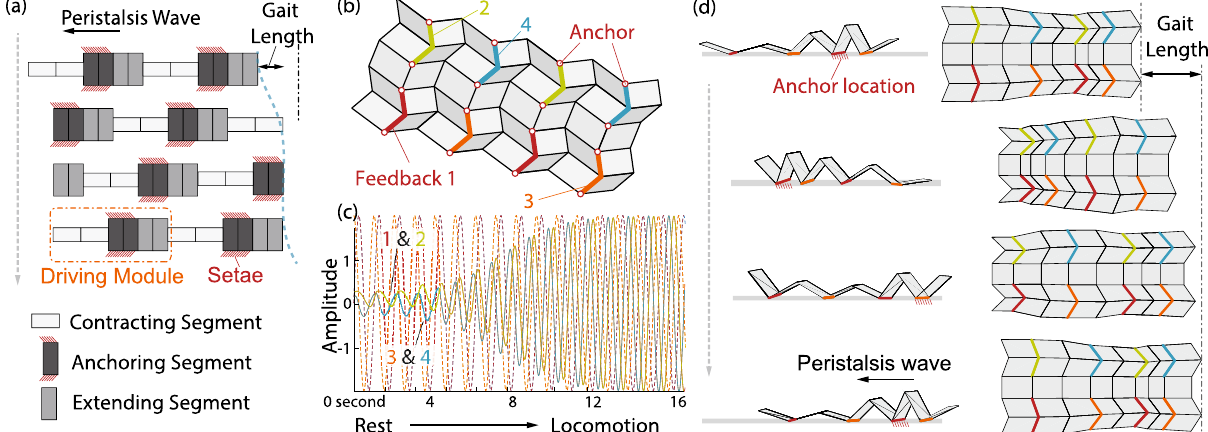
Figure 10. Reservoir computing powered crawling origami robot. ( a ) The kinematics of a peristaltic locomotion cycle in an earthworm. For clarity, the earthworm body is simplified and consists of six identical segments organized into two driving modules. The earthworm body moves forward while the peristaltic wave of anchoring segments (or driving modules) propagates backward. ( b ) The design of an earthworm inspired origami crawling robot that features two stripes of Miura-ori connected by a zig-zag shaped “ridge.” This robot has four groups of feedback creases. ( c ) The closed-loop trajectory generated by the feedback creases after training (shown in solid lines) superimposed with the targetted trajectory (shown in dashed lines). ( d ) Peristaltic locomotion cycle in the origami robot as a result of the generated